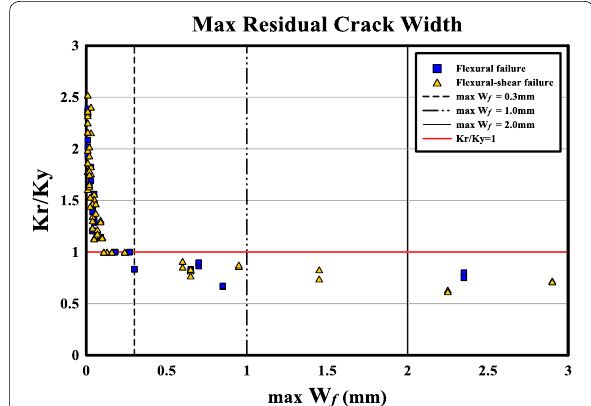
Fig. 16 Relationship between the maximum residual flexural crack width and residual stiffness for the specimens with the flexural and flexural–shear failure modes.